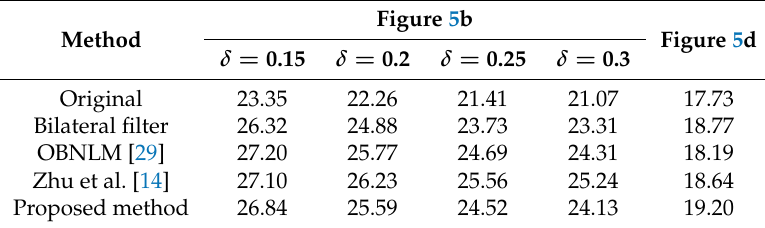
Table 2. The structural similarity (SSIM) metric of various methods on the two synthetic images in Figure 5. Figure 5b Method δ = 0.15 δ = 0.2 δ = 0.25 δ = 0.3